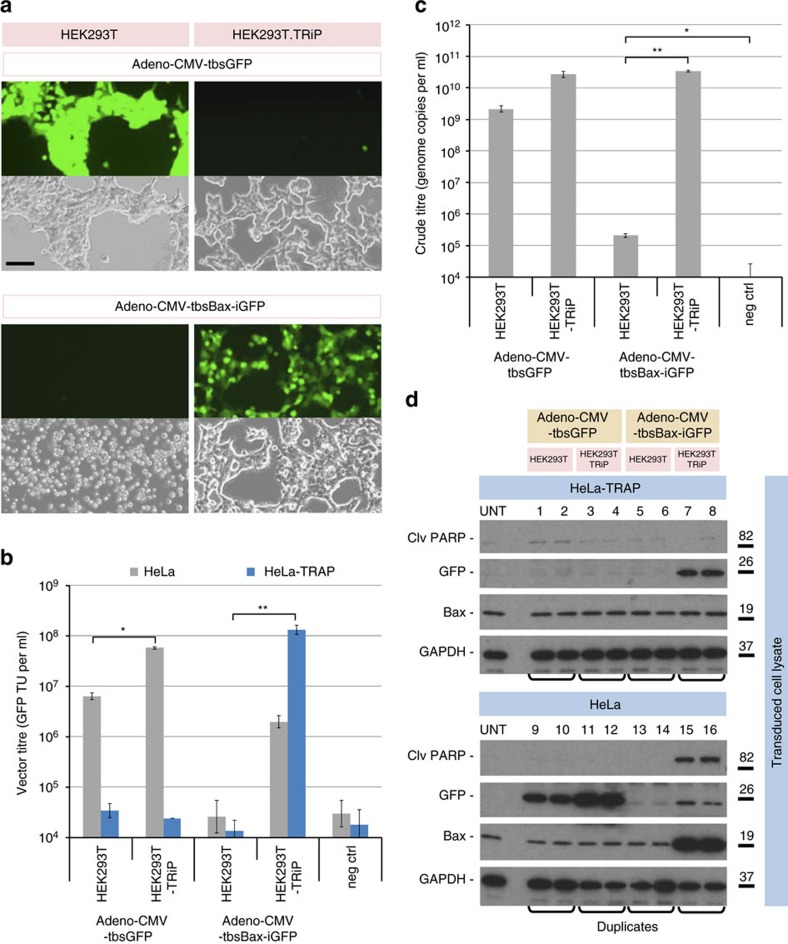
Proof-of-principle TRiPAdeno vector production using the apoptotic transgene Bax.(a) Representative phase or fluorescent microscopy images of HEK293T or HEK293T.TRiP cell cultures in the first amplification phase post-inoculation with Adeno-CMV-tbsGFP or Adeno-CMV-tbsBax-iGFP vectors produced in HEK293T.TRiP cells (black scale bar=100 μm). (b) Vector stocks from the final round of amplification/passaging were titrated on HeLa cells and HeLa-TRAP cells. Data are mean average values±s.d. [log10-transformed data] (n=3); *P<5.4 × 10−4, **P<1.5 × 10−4 [Welch's t-test]. (c) Vector stocks from the final round of amplification/passaging were titrated by qPCR of purified vDNA using a GFP primer/probe set. Data are mean average values±s.d. [log10-transformed data] (n=3); *P<3.1 × 10−2, **P<6.7 × 10−8 [Welch's t-test]. (d) Vector stocks from the final round of amplification/passaging were used to transduce HeLa and HeLa-TRAP cells at an MOI ∼5, and transduced cell lysates analysed for functional expression of transgene cassettes by immunoblotting to Cleaved-PARP (induced by Bax over-expression), Bax, GFP and GAPDH (molecular weight marker in kilodaltons). Triplicate Adenoviral vector stocks were derived and amplified/passaged from three independent recombination steps; qPCR and immuoblotting were each repeated twice.